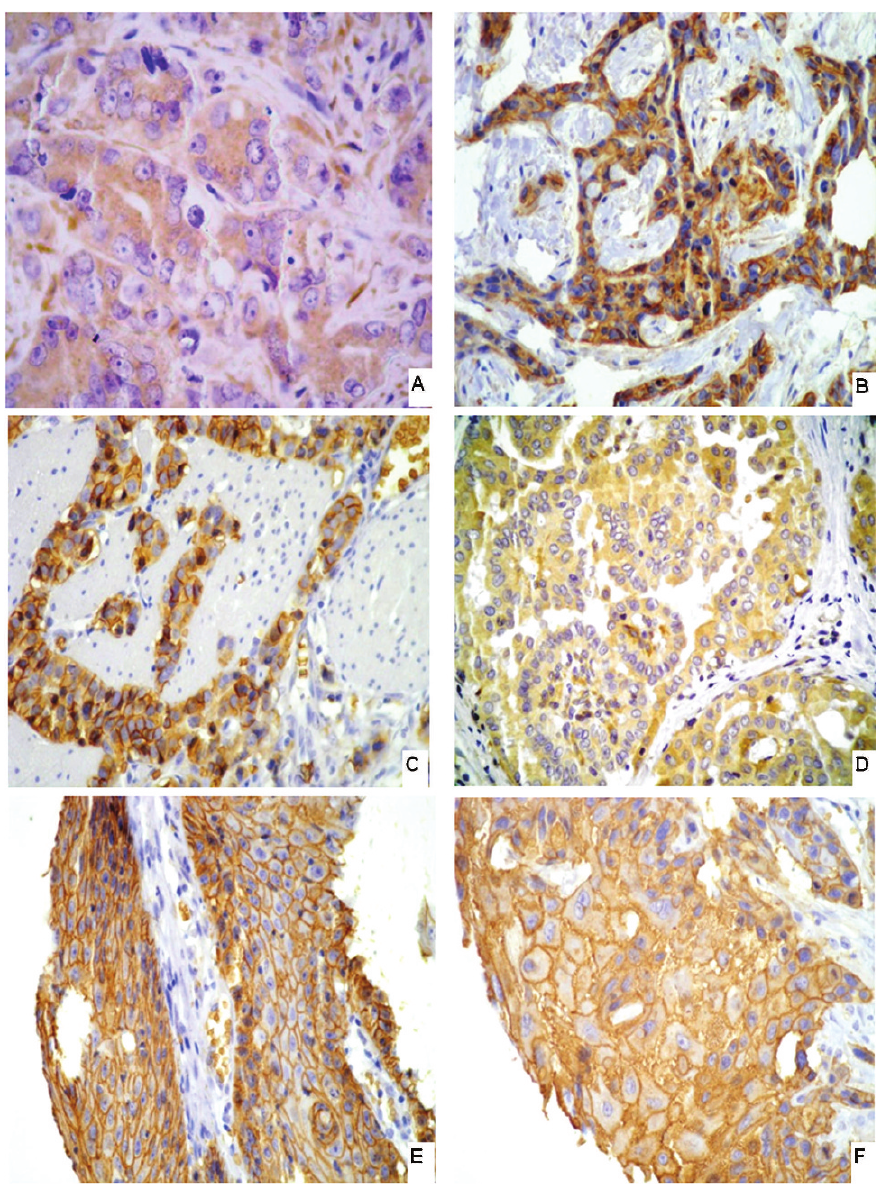
Figure 3 - Cytoplasmic GLUT1 expression in adenocarcinomas and membrane expression in squamous cell carcinomas. A, prostate tumor; B, papillary thyroid tumor; C, gastric tumor; D, breast tumor; E, squamous cell carcinoma of uterine cervix; F, squamous cell carcinoma of the head